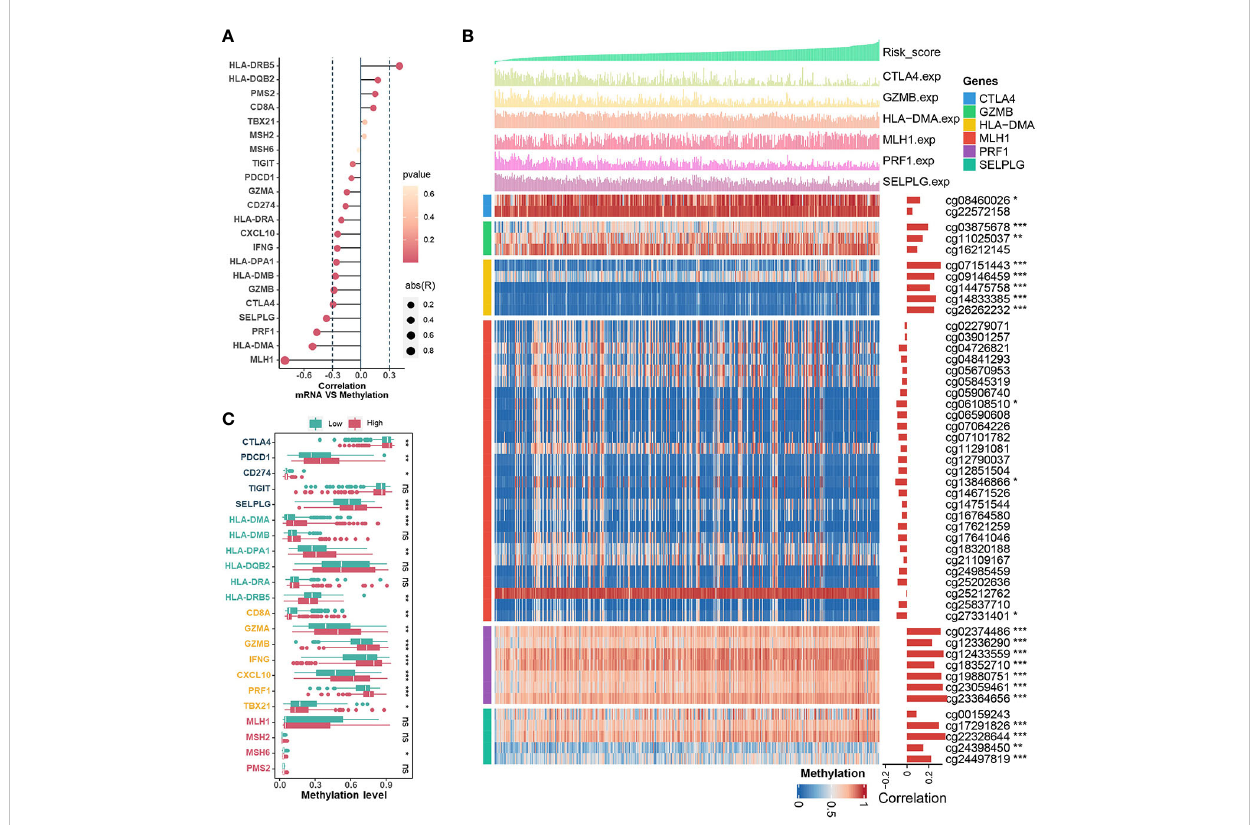
FIGURE 6 The Relationships Between CRRS and DNA methylation. (A) . The bubble chart shows the correlation between expression levels and methylation levels of the immune-related genes. The length of the vertical line indicates the degree of correlation, and the color indicates the p -value. (B) The correlation between the CRRS and the methylation levels of CpG sites in the promoter region of the MLH1, HLA-DMA, PRF1, SELPLG, CTLA4, and GZMB genes. (C) . Comparisons of the methylation levels of immune-relation pathway genes (Mismatch Repair signature, CD8 + T effector signature, Antigen presentation signature, and Immune Checkpoint signature) in low- and high-CRRS